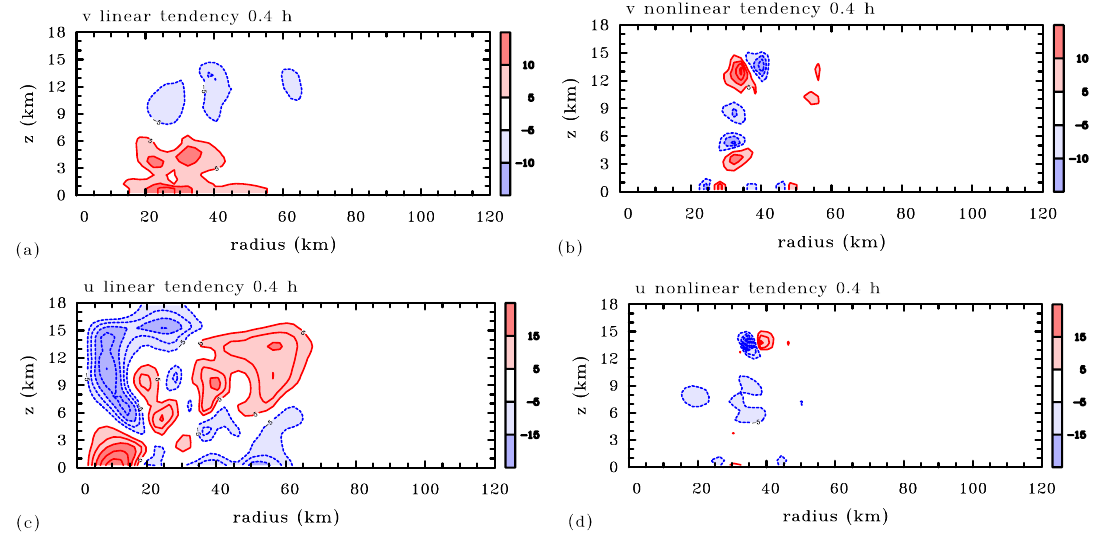
Figure 4. Linear tendency terms diagnosed from the 3DVPAS model and corresponding nonlinear tendency terms evaluated using the linear solutions at t = 0.4 h integration time. Shown in a radius-height coordinate system are ( a ) linear terms from the disturbance tangential velocity equation; ( b ) nonlinear terms in the disturbance tangential velocity equation (Equation (8)) evaluated using the linear solutions; ( c ) linear terms in disturbance radial velocity equation; ( d ) nonlinear terms in disturbance radial velocity equation (Equation (7)) computed using linear solutions. Contour interval for all panels is 5 m s − 1 h − 1 , solid positive and dashed negative.